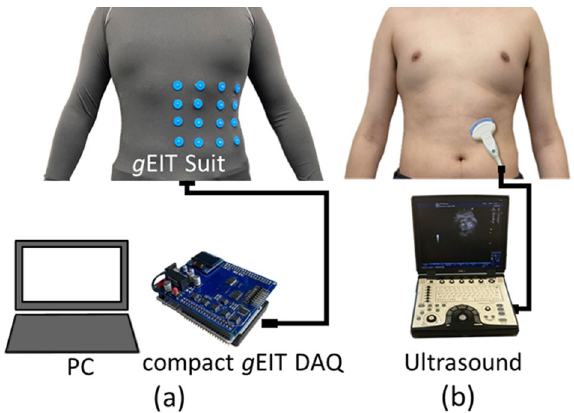
Figure 4. Experimental Setup ( a ) g EIT system experimental setup, ( b ) ultrasound experimental setup.